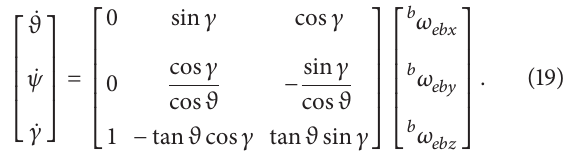
sample over a fixed time interval. Due to the sampling num- ber of a triaxial gyro, single-sample algorithm, two-sample algorithm, three-sample algorithm, and so on have been developed, and the validity of algorithm is described by drifting